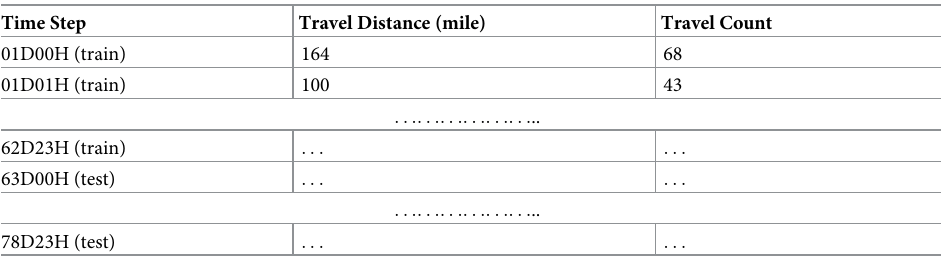
Table 2. Summary of sample